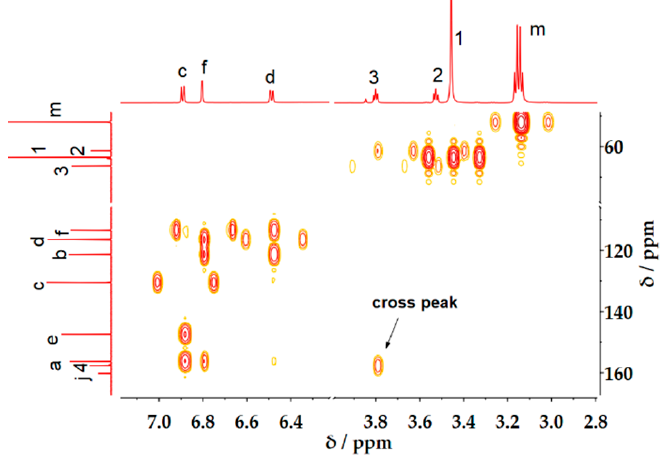
Figure 3. The 1 H– 13 C HMBC spectrum of [Et 4 N] [Car]:EG (1:2) + CO 2 . Letters from a to j are the